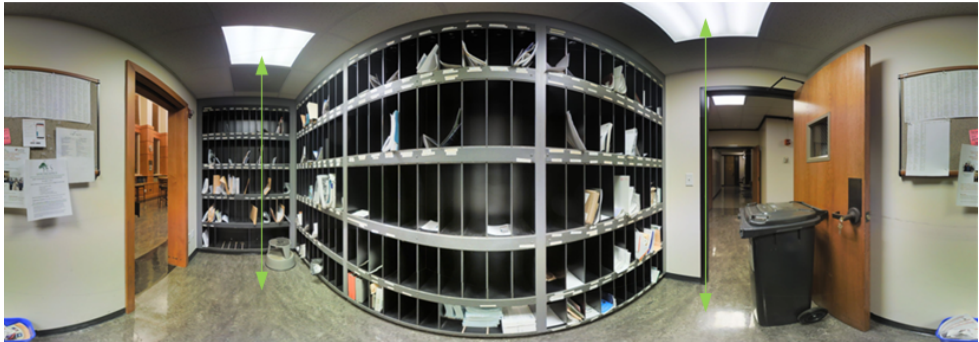
Figure 3. Correspondence between the ceiling and